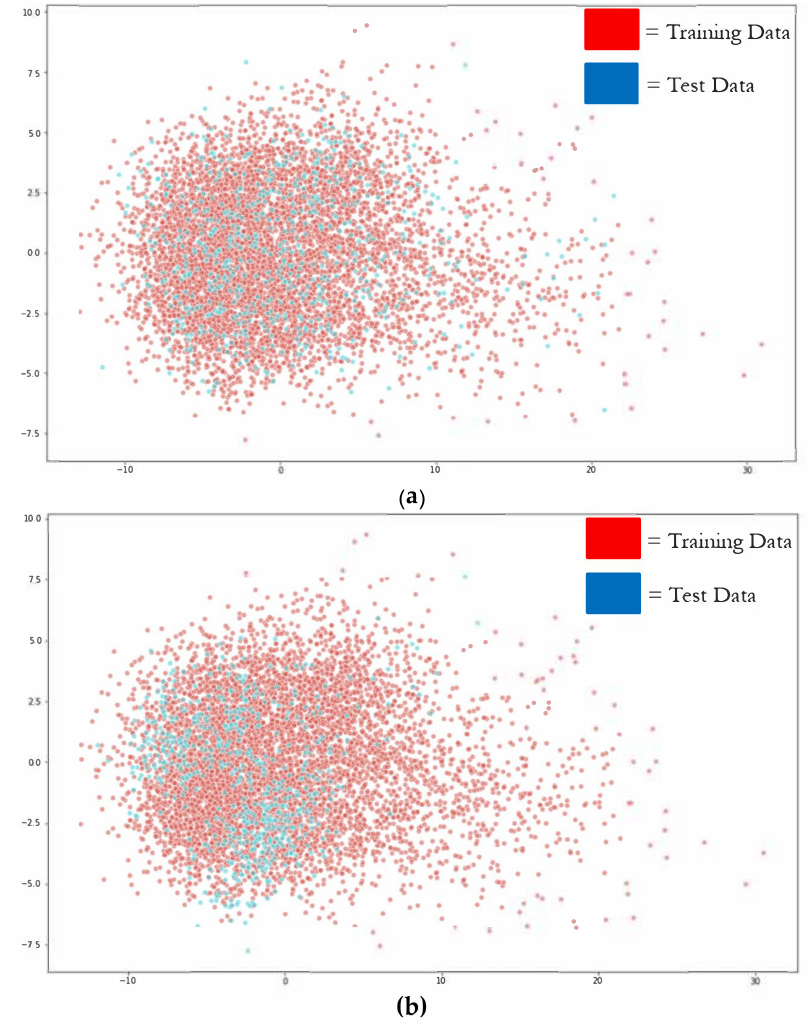
Figure 4. PCA projection of the first two principal components for ( a ) Improper and ( b ) Proper methods of dataset partitioning for spectral features of the Driver Fatigue dataset [33]. Red dots represent training data observations, and blue dots represent test data observations. Note that in the improper ( a ) that the test distribution is more uniformly spread throughout the training distribution, as all 12 participants are in the test distribution, while in the proper ( b ), the test distribution is more clustered due to the entire test distribution belonging to a single participant. These graphs are newly generated from the data obtained in the Driver Fatigue dataset